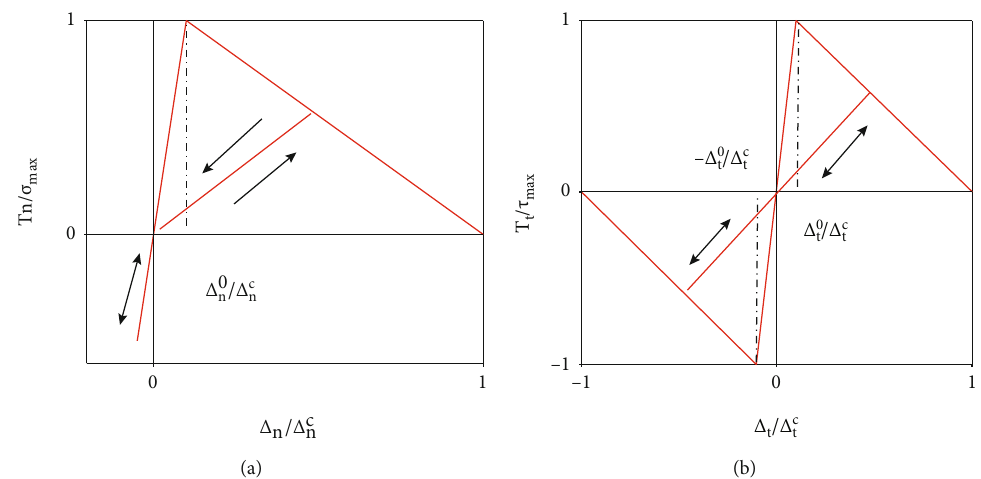
Figure 1: Bilinear cohesive relation of the pure mode I and mode II in ABAQUS.